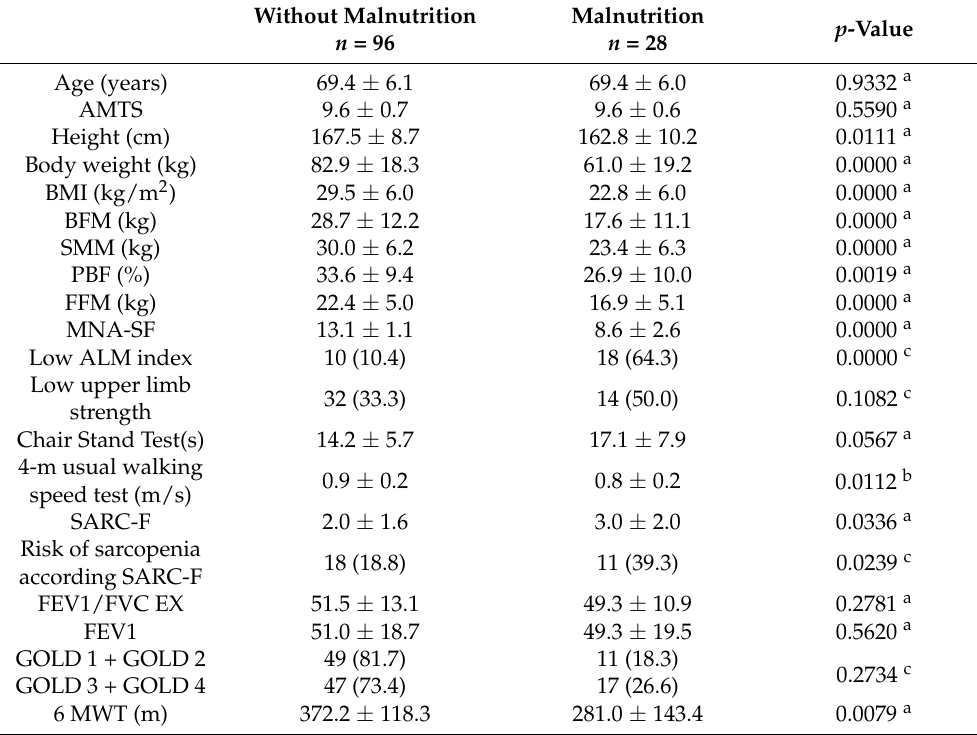
Table 1. Characteristics of subgroups with and without malnutrition according to the GLIM criteria.